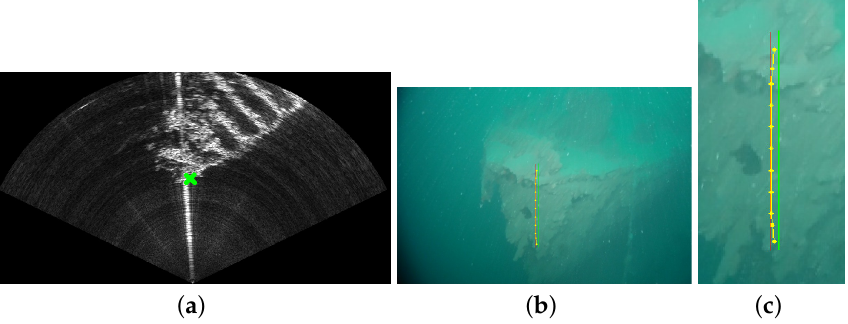
Figure 9. ( a ) The selected sonar point in green. ( b ) The corresponding projected points in the optical image, with the starting (green), ending (red), and estimated points (yellow); a zoomed image of the projected points is proposed in ( c ).